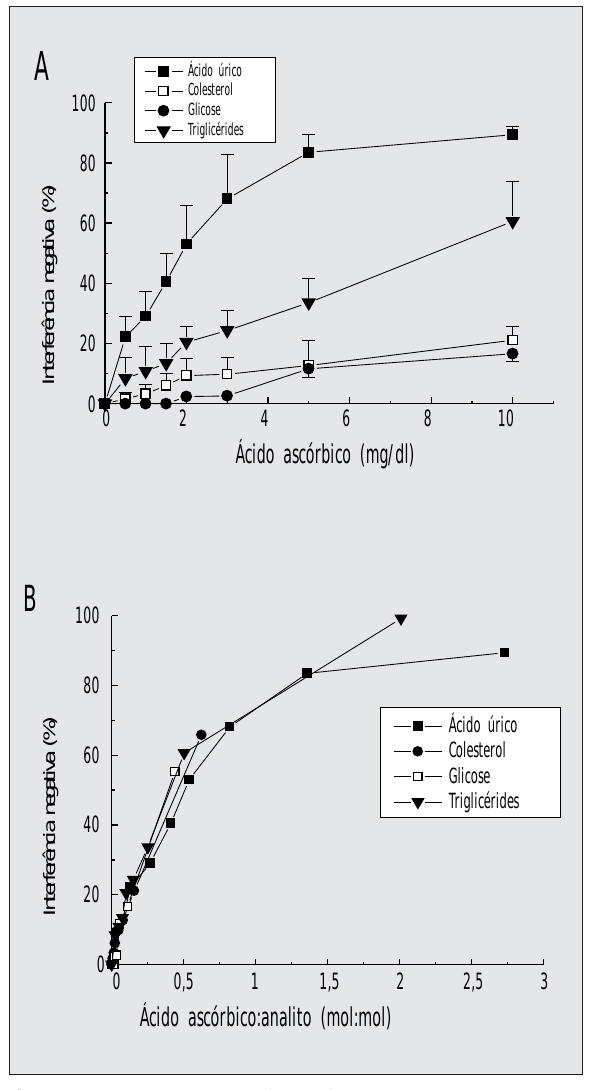
Figura 2 – Interferência negativa do ácido ascórbico in vitro na determinação de ácido úrico, colesterol, glicose e triglicérides pelo sistema oxidase/peroxidase. A) Ácido ascórbico foi adicionado ao soro (concentração final), e as determinações dos analitos foram realizadas antes (controle) e 1-2 horas após a adição. B) Os resultados foram normalizados em termos molares de ácido ascórbico:analitos. Os resultados são média – desvio padrão dos ensaios realizados com os reagentes de Labtest,